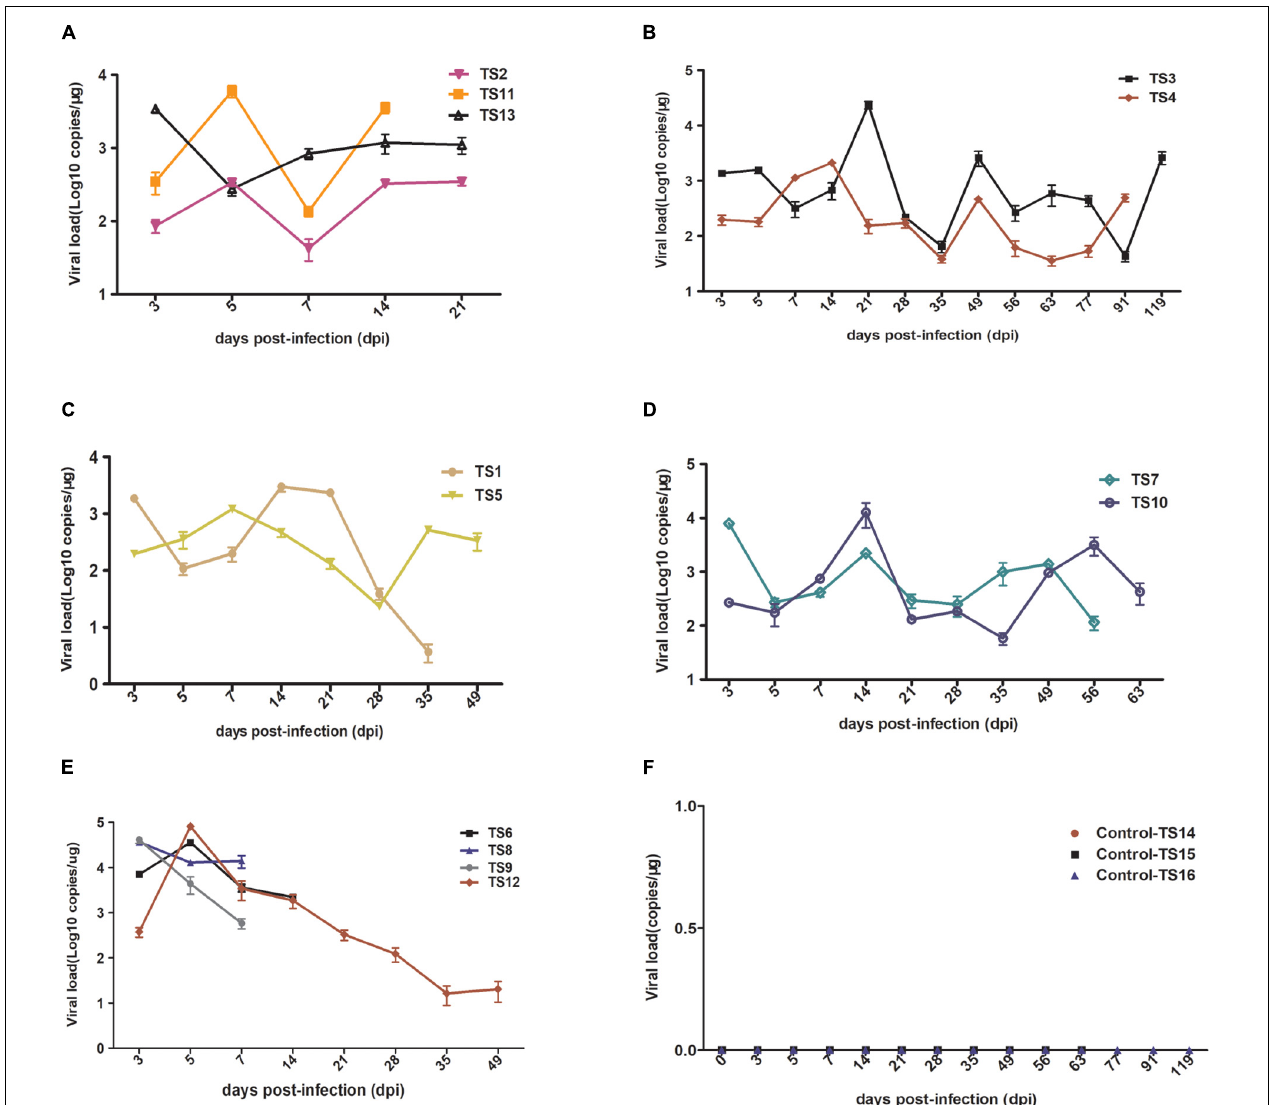
FIGURE 4 | Detection rKSHV.219 copy number in peripheral blood of tree shrews TS1–13. TS14–16 were used as the negative control (NC); nothing was detected. (A) Intermittently increased in TS1, TS11, and TS13 at 14 and 21 dpi. (B) Intermittently increased in TS3 and TS4 at 91 and 119 dpi. (C) Intermittently increased